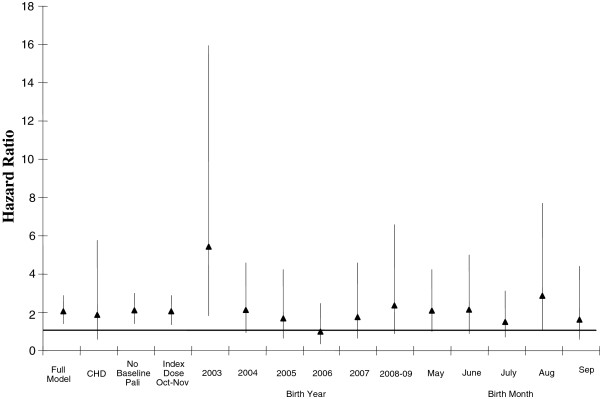
Hazards for RSV-related hospitalization associated with palivizumab non-compliance for select population subsets*. *Data representing CLD have been omitted from this graph due to small sample size and large confidence interval (3.3 – 79.9).